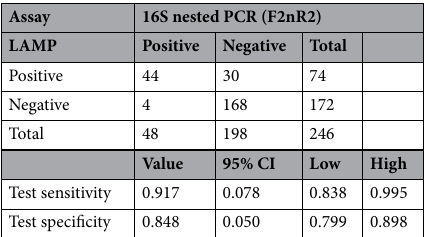
Table 3. Sensitivity and specificity of the LAMP assay, using nested PCR targeting the 16S rRNA-encoding gene as a gold standard. 95% CI 95% confidence interval, calculated as described by Banoo et al. 25